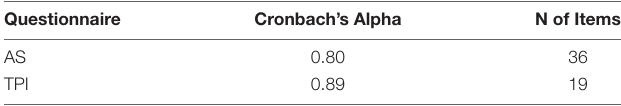
TABLE 1 | Reliability of the TPI and AS